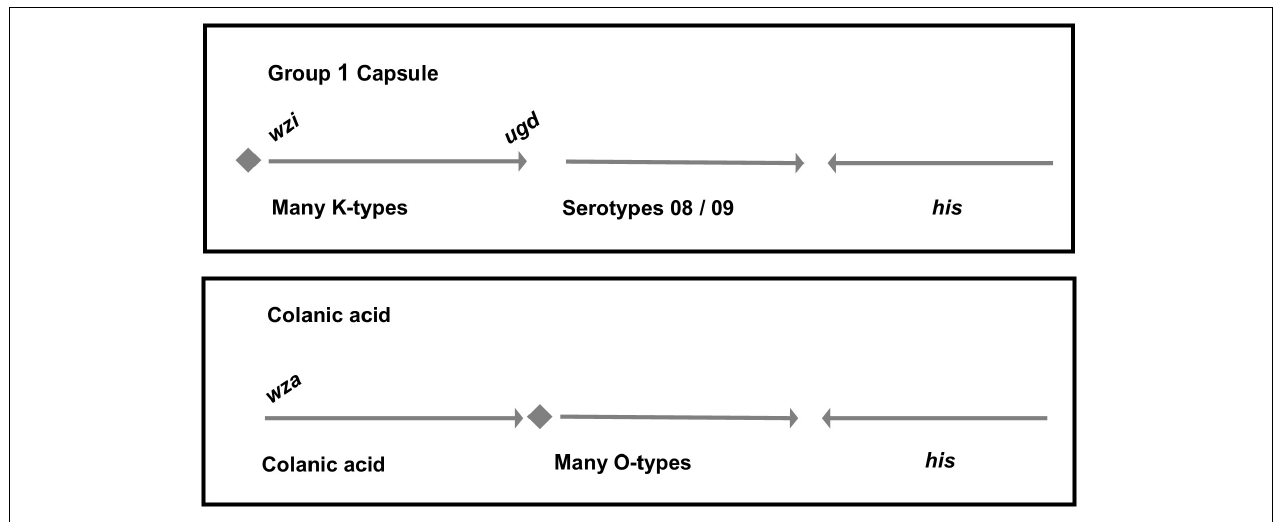
FIGURE 2 | Differences in the genetic organization between E. coli group 1 and colanic acid capsules. In both groups, capsule and O-antigen gene clusters are located near the operon for histidine biosynthesis. In group 1 capsules, galF and a JUMPStart sequence (represented together as a diamond shape) are located upstream of the capsule genes. The first structural gene of the capsule, wzi, is unique to group 1 capsules. By comparison, strains which produce colanic acid have the galF and JUMPStart region upstream of the O-antigen. The final gene in the colanic acid locus is wcaM which is absent in group 1 capsule